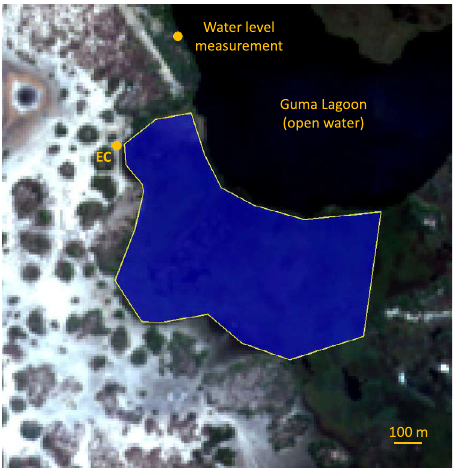
Fig. 7 RGB Sentinel-2 imagery of the area surrounding the eddy- covariance (EC) tower at Guma Lagoon (18°57 ′ 53.01 ″ S; 22°22 ′ 16.20 ″ E). The region of interest, from which pixels were sampled to calculate the enhanced vegetation index (EVI) of the fl oating papyrus stand, is shown as a blue polygon. The approximate location of the water level measurement sensor is also